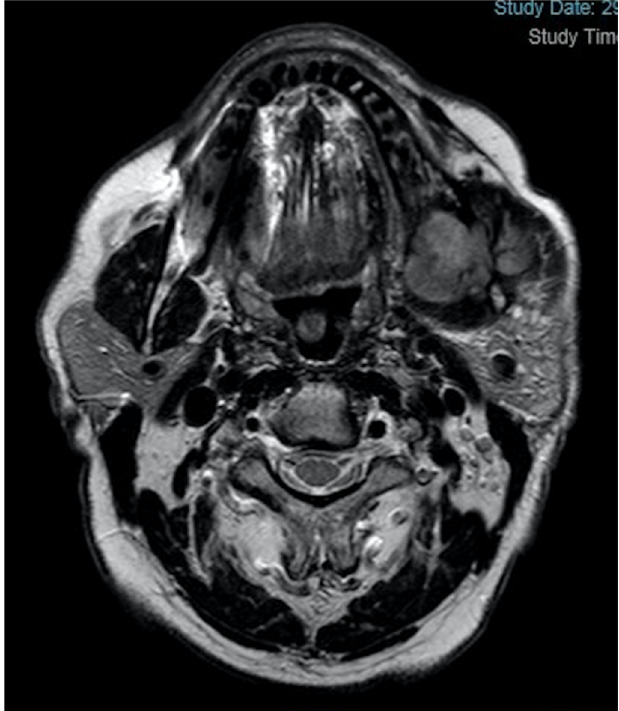
Fig. 4. T1 time MRI in axial section, at 6 years, through the mandible, showing the expansive process in relation to the ascending branch of the mandible.